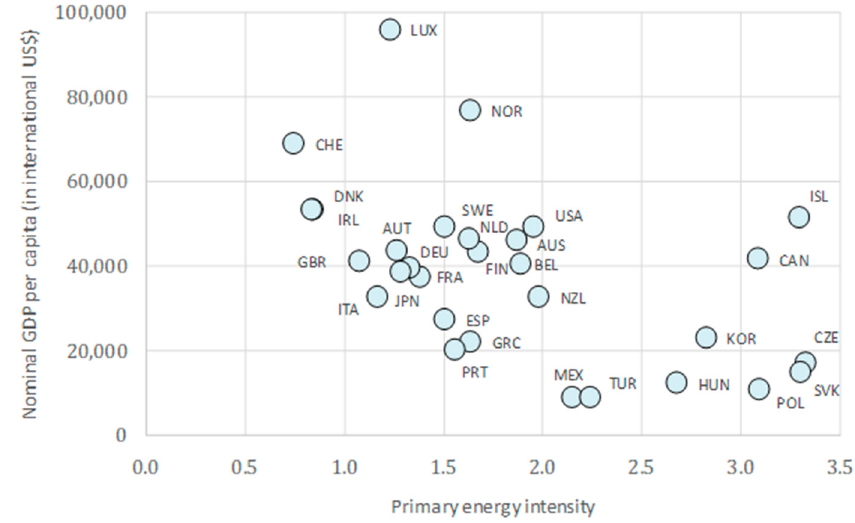
Figure A3. Primary energy intensity and nominal GDP per capita.